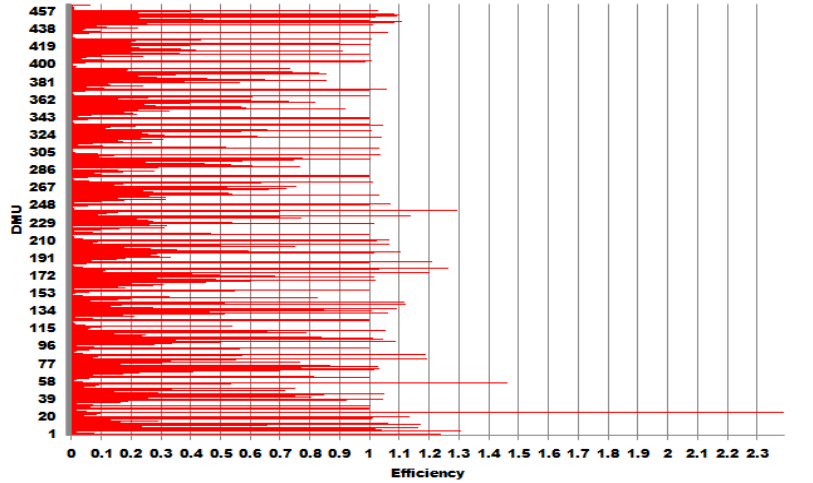
Figure 6. Comparison of regional forestry ecological efficiency (FEE) in China from 2004 to 2018.